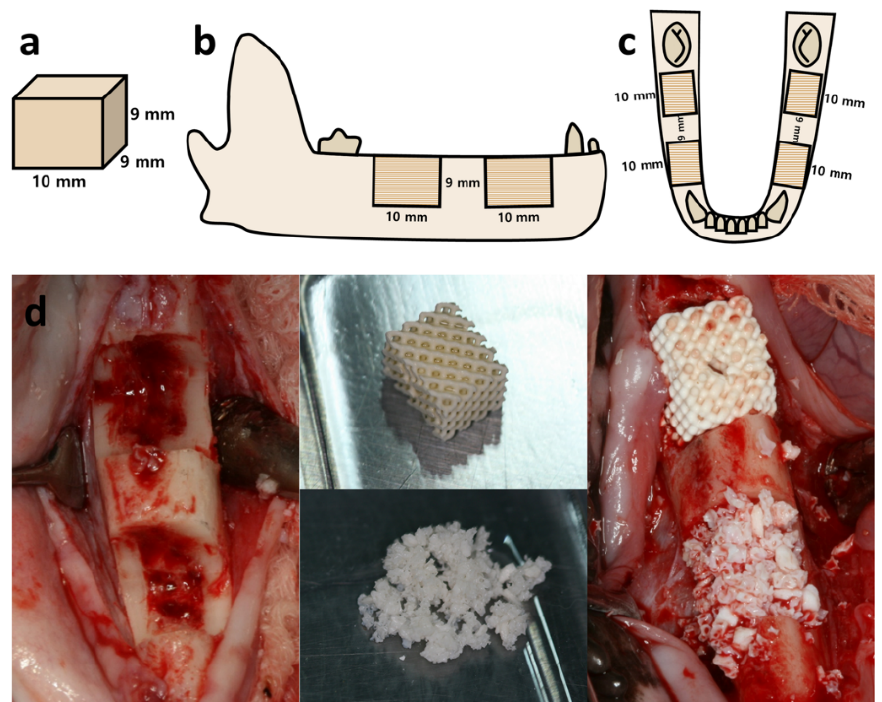
Figure 5. Design of the defect and actual surgical procedure in the mandible of the beagle: ( a ) the shape and size of the defect; ( b ) defect design on the lateral view; ( c ) defect design on the occlusal view; ( d ) surgical procedure.